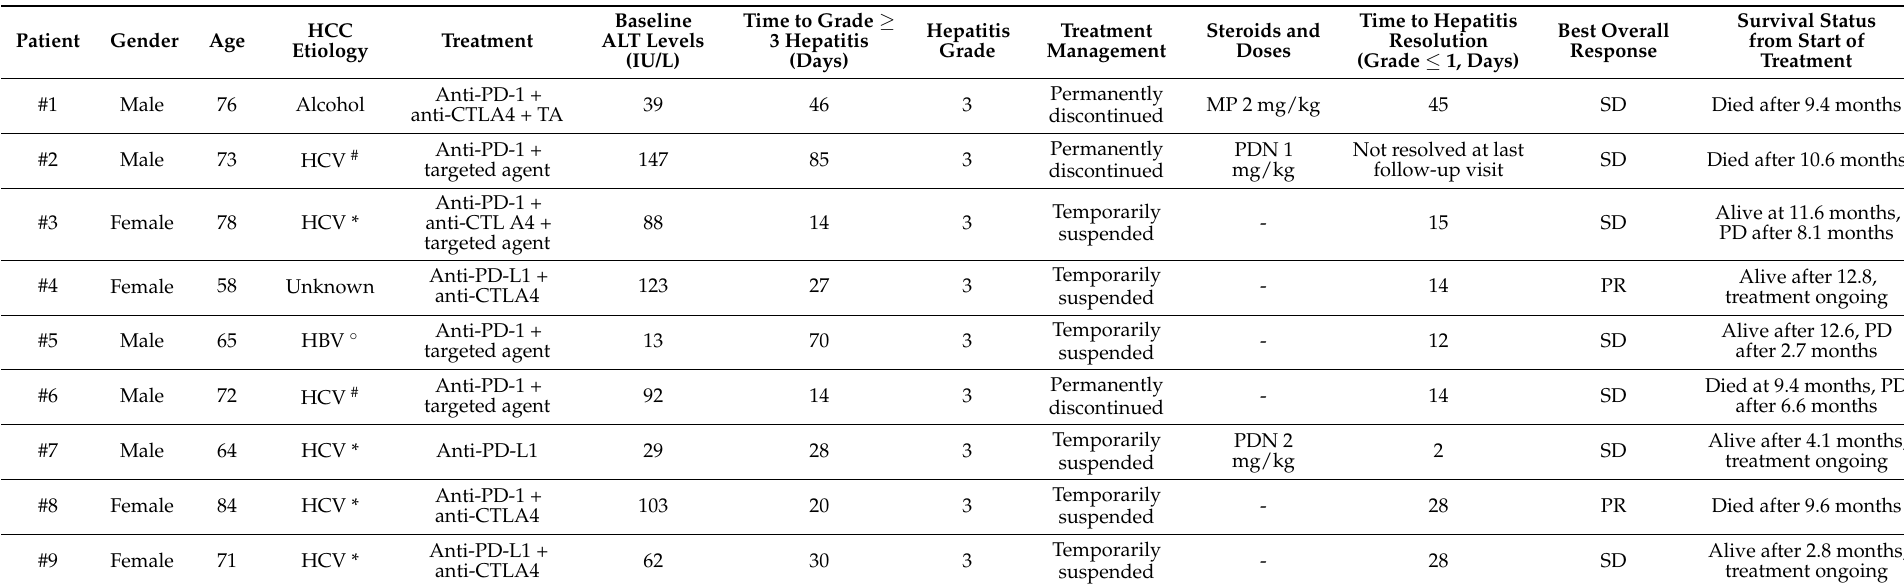
Table 2. Summary of cases of immune-related hepatitis grade ≥ 3 according to the CTCAE version